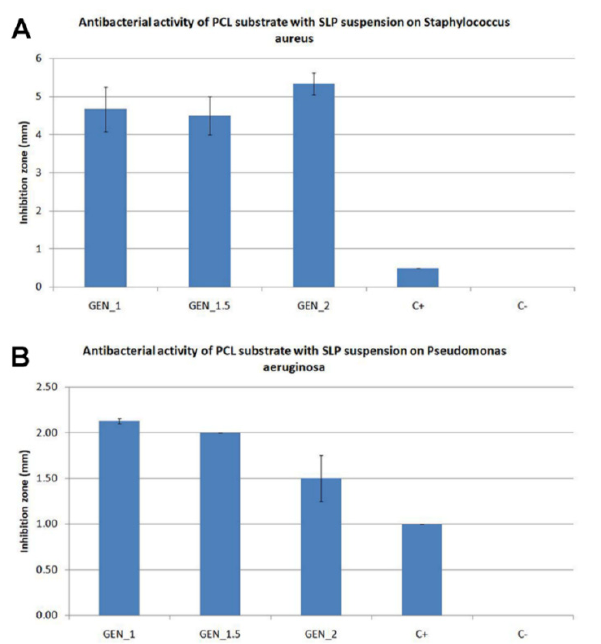
Figure 6. Influence of doses of antibacterial SLP with different volumes of gentamicin (GEN) solution substance on each bacterial strain ( A ) S. aureus (SA) and ( B ) P. aeruginosa (PA) after 20 h of incubation on agar plate at temperature 37 °C, C+ = control with silver, and C − = PCL substrate without lipid suspension. The statistical analysis shows there is not statistically significant difference for STAU ( p = 0.152) or for PSAE ( p = 0.164), (STAU— S. aureus , PSAE— P. aeruginosa ). The first sample GEN_1 includes 1 mL of the gentamicin solution in the suspension, the second sample GEN_1.5 includes 1.5 mL of the gentamicin solution in the suspension, and the last sample GEN_2 includes 2 mL of the gentamicin solution in the suspension.